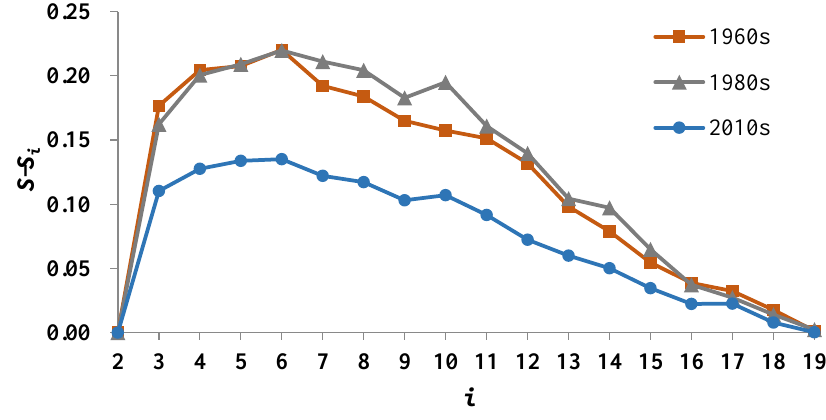
Figure 5. Change curve of the difference value between S and S i at each time.